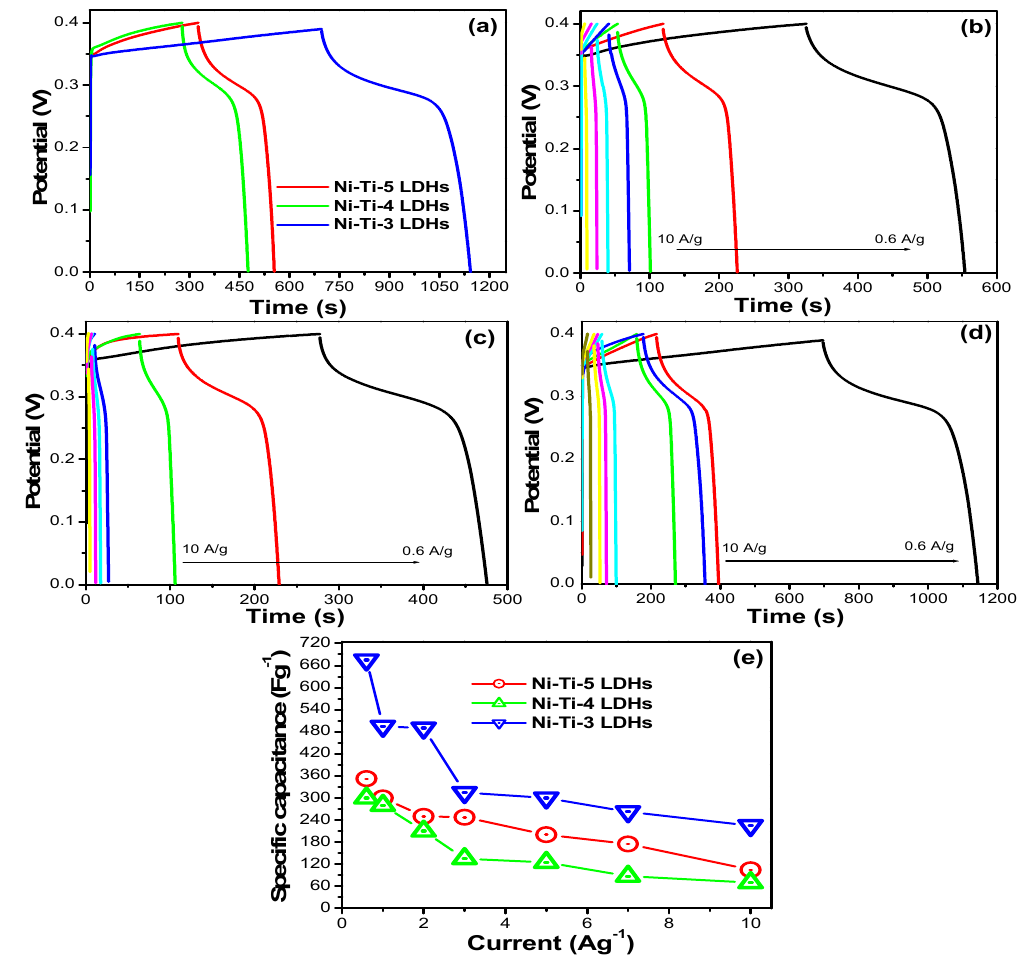
Figure 11. ( a ) Comparative GCD curves of all the LDHs, ( b ) GCD curve of the Ni-Ti-5 LDHs ( c ) GCD curve of the Ni-Ti-4 LDHs, ( d ) GCD curve of the Ni-Ti-3 LDHs at different current density, and ( e ) specific capacitance of all the LDHs at different current density.